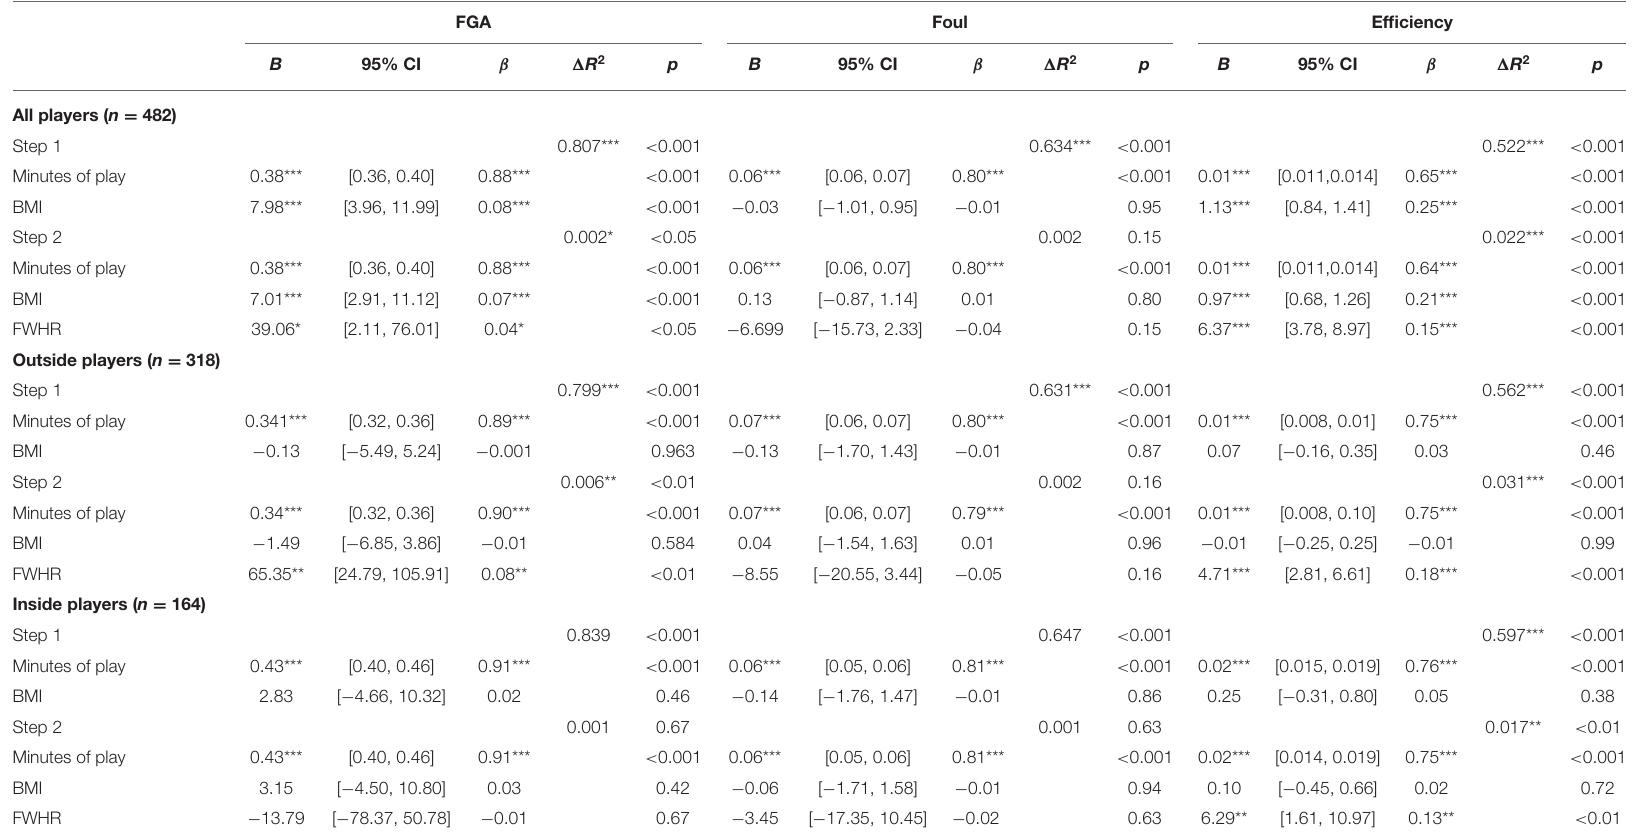
TABLE 3 | Results of regression analyses for FGA, Foul, and